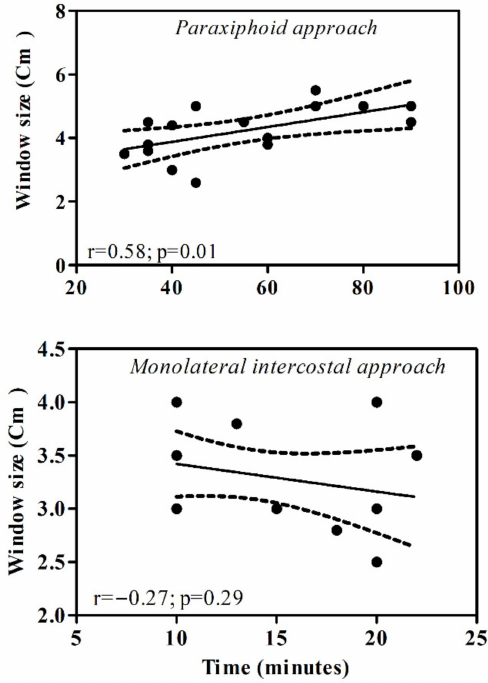
Figure 3. Scatter plot of the surgery time vs. pericardial window size in each surgical treatment. The distribution data showed a linear regression for the paraxiphoid